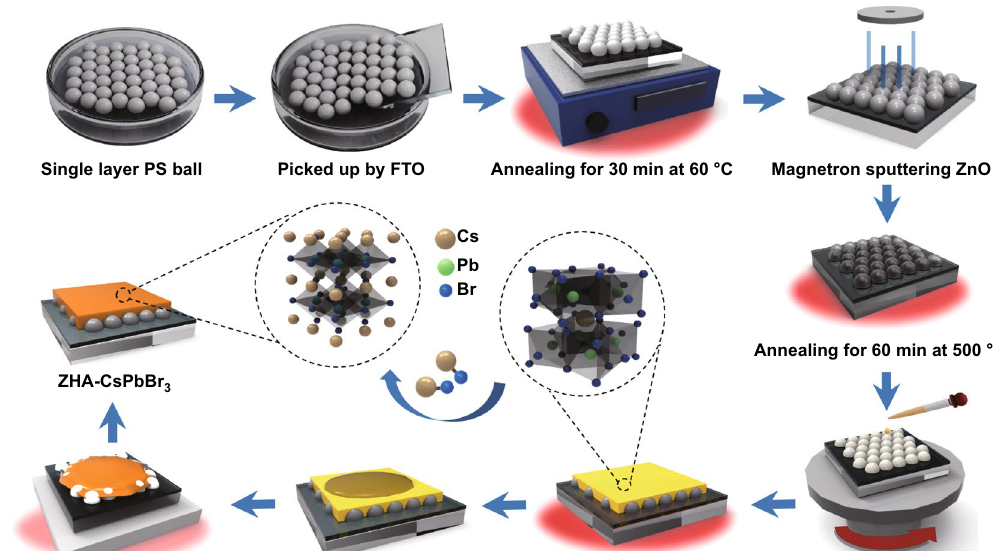
Fig. 1 Preparation process of the ZHA/CsPbBr 3